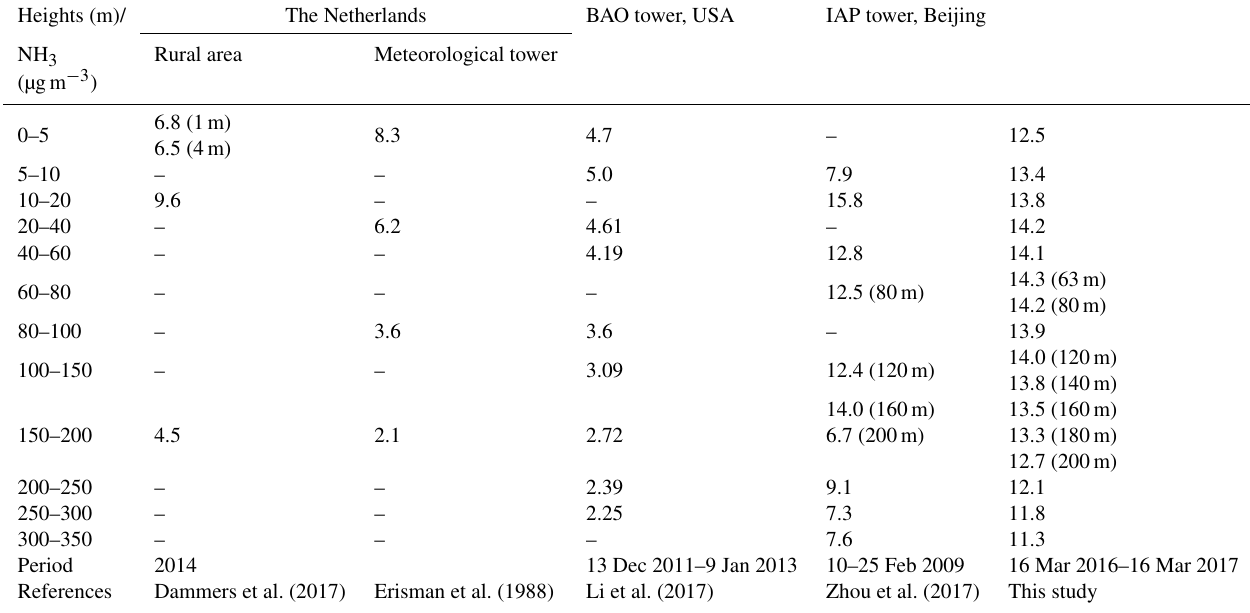
Table 1. Overview of measured vertical NH 3 concentrations (µgm − 3 ) in previous studies and in this study. Heights (m)/ The Netherlands BAO tower,